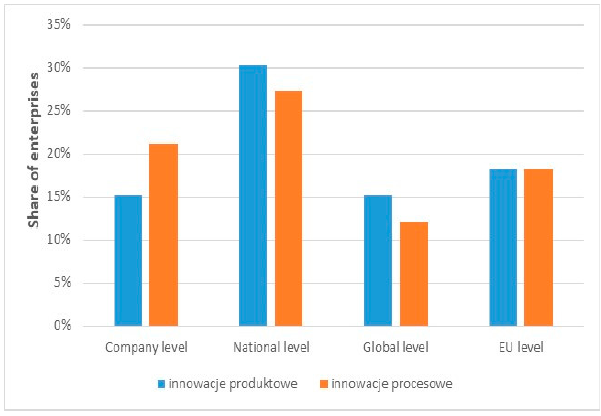
Figure 2. Scope of innovations.